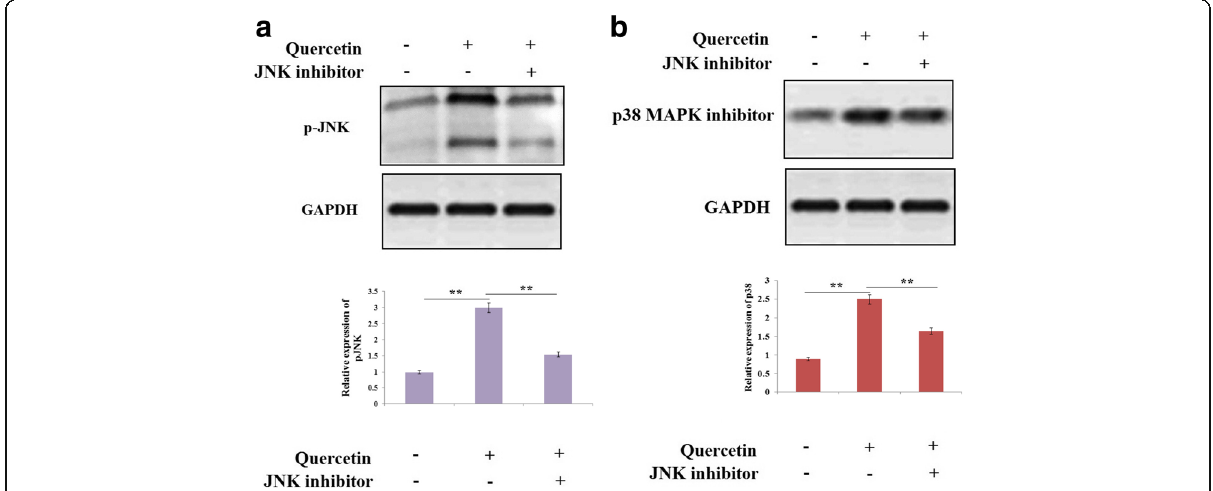
Fig. 6 Study suggesting effect of JNK and MAPK inhibitors on Quercetin-mediated activation of JNK and p38 MAPK. a and b The RB Y79 cells were exposed in the presence or absence of JNK inhibitor and p38 MAPK inhibitor for time period of 1 h followed by treatment with 100 μ M Quercetin for 24 h. The levels of phosphorylation of JNK and p38 MAPK were evaluated opting western blot analysis, in which GAPDH was opted as loading control. ** P < 0.01 (n = 3)